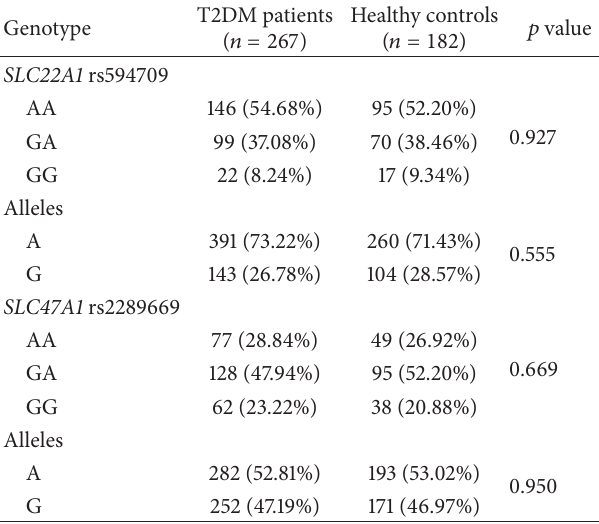
Table 2: Comparisons of allelic frequencies of SLC22A1 rs594709 and SLC47A1 rs2289669 polymorphisms in T2DM patients and healthy